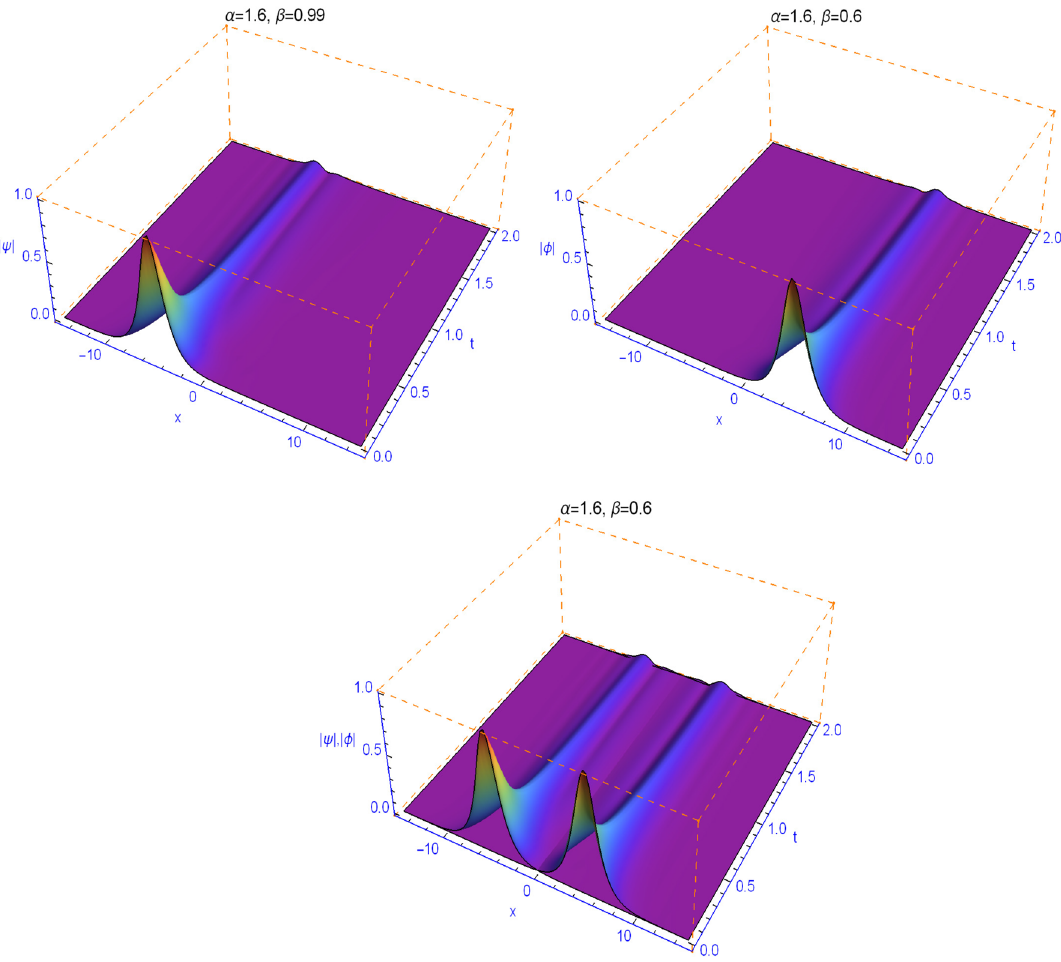
Figure 5. Plots of model (36) for β = 0.6 and α = 1.6